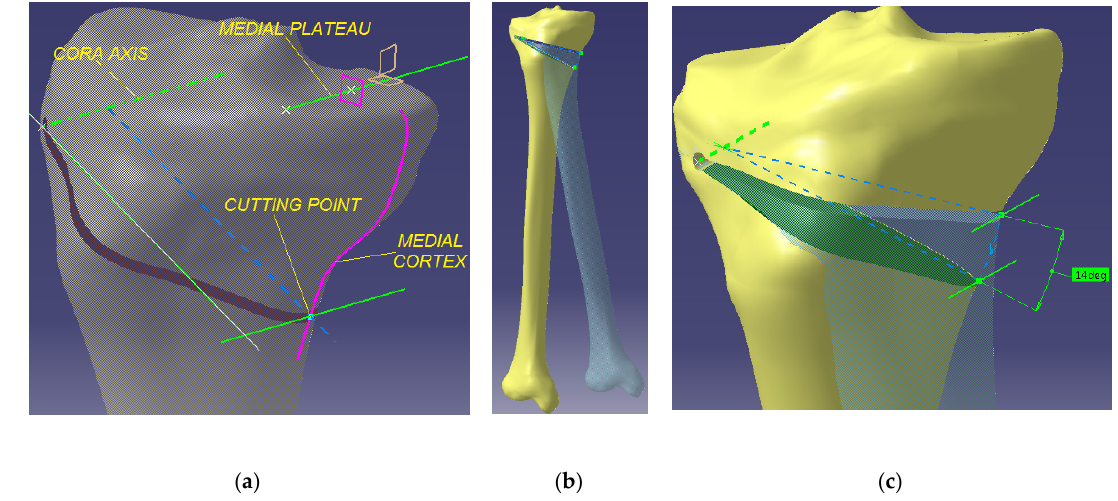
Figure 3. 3D modelling of the medial open wedge HTO surgery: ( a ) geometrical elements; ( b ) 3D rotation; ( c ) correction angle.